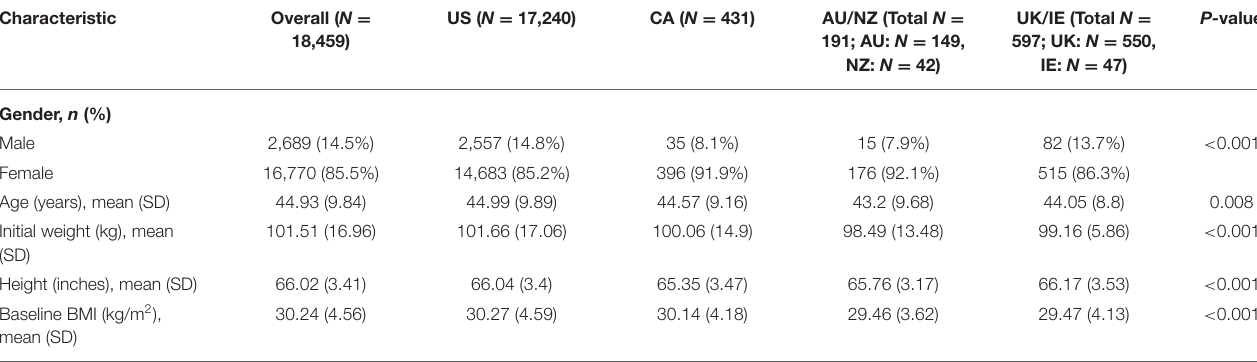
TABLE 1 | Descriptive statistics for baseline characteristics by region.